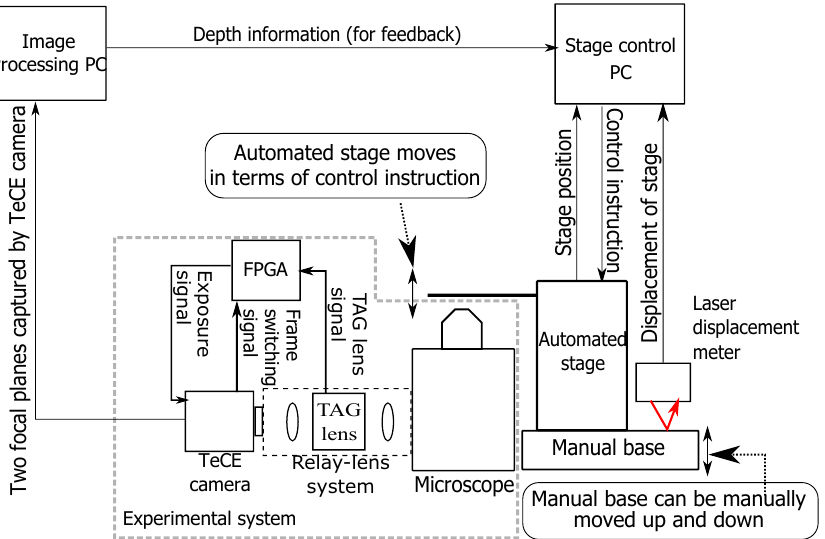
Figure 10. Arrangement of experimental system for focus